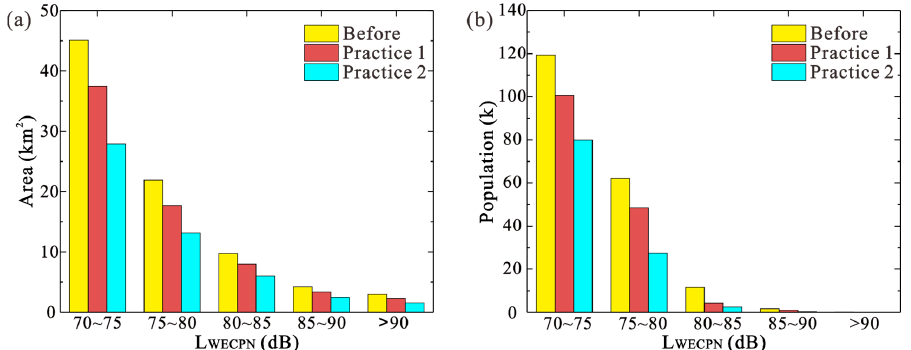
Figure 7. Noise reduction effects before and after the reduction in night flights in two stages during summer. ( a ) area ( b ) population.